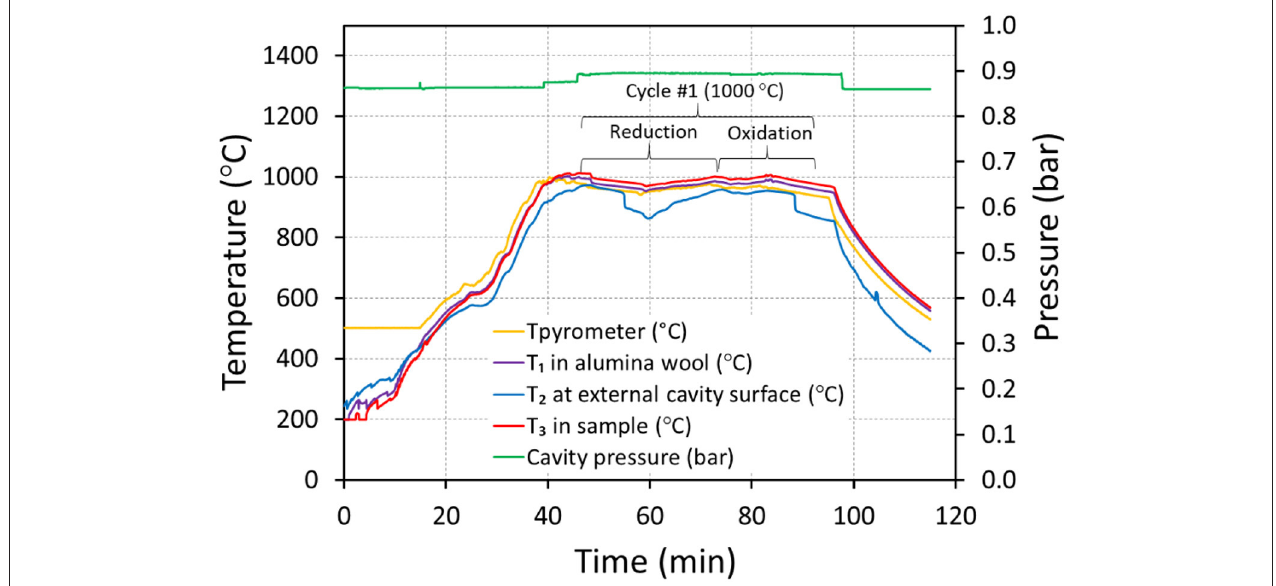
FIGURE 4 | Temperature and pressure evolution in the reactor during the heating phase, ceria foam reduction with methane and oxidation with H 2 O (CeF-1400: mass 30.963g, cycle #1).